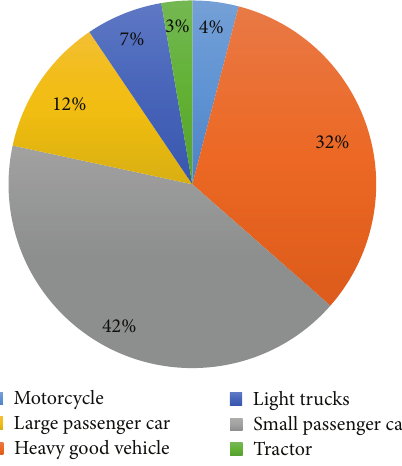
Figure 14: Vehicle types in e-bike fatal